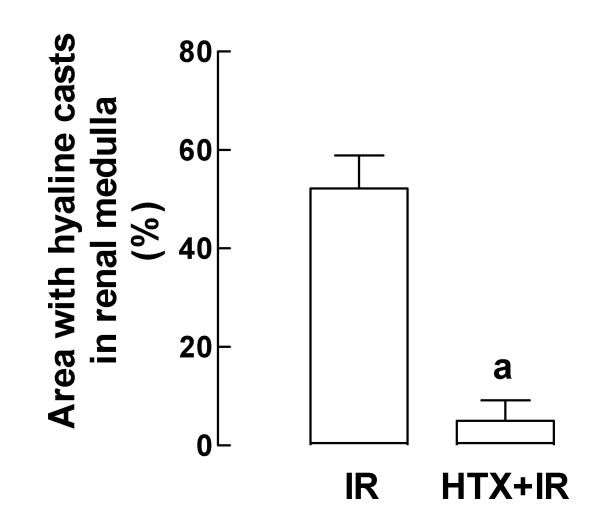
Quantitative analysis of damage in the renal medulla of rats from IR and HTX+IR groups. Area of tubular lumen with hyaline casts is shown as percentage. n = 4 rats, and 60 tubular lumen/rat. Mean ± SD. aP < 0.001 vs. IR.